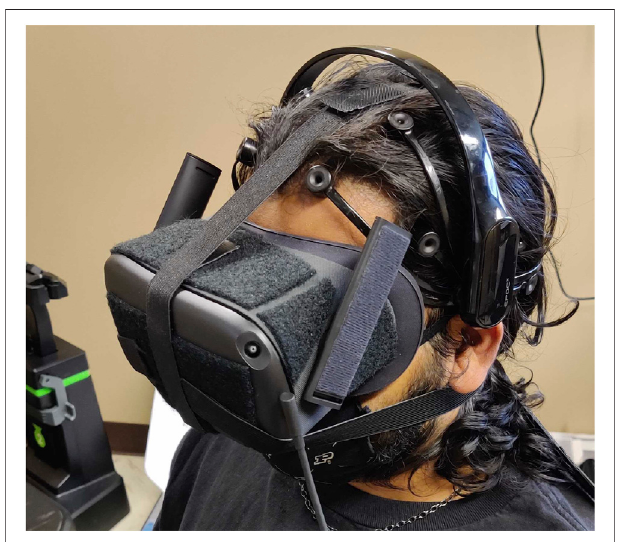
FIGURE 4 | Participant wearing the Emotiv EEG headset and Oculus Quest VR headset.